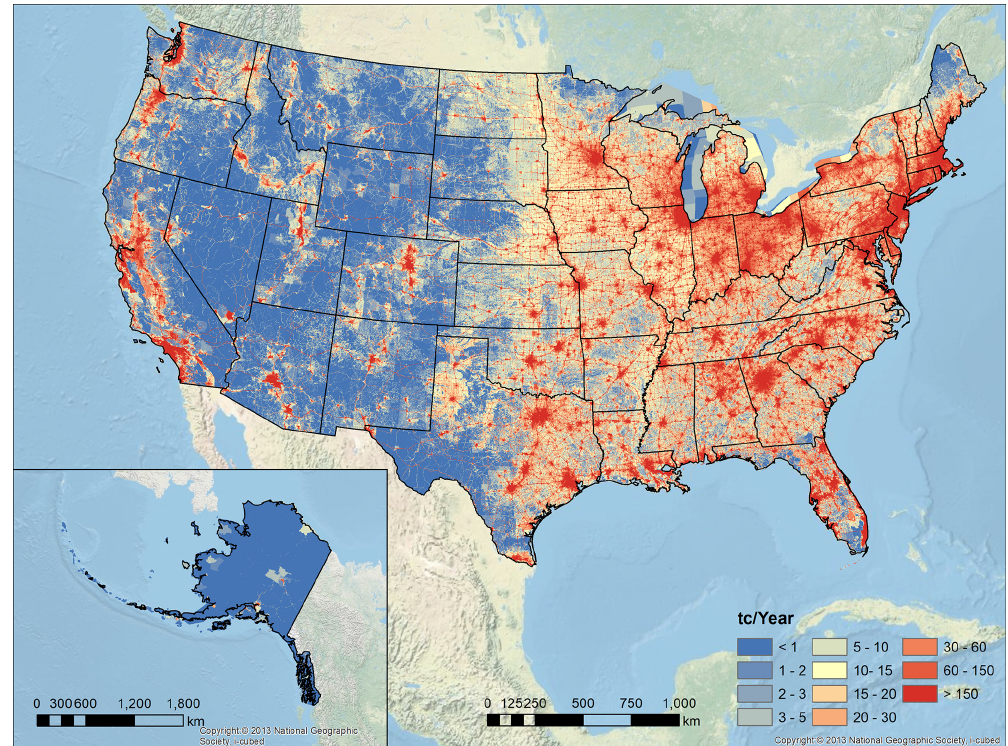
Figure 2. Total annual FFCO 2 emissions for the year 2011 from the Vulcan v3.0 output.